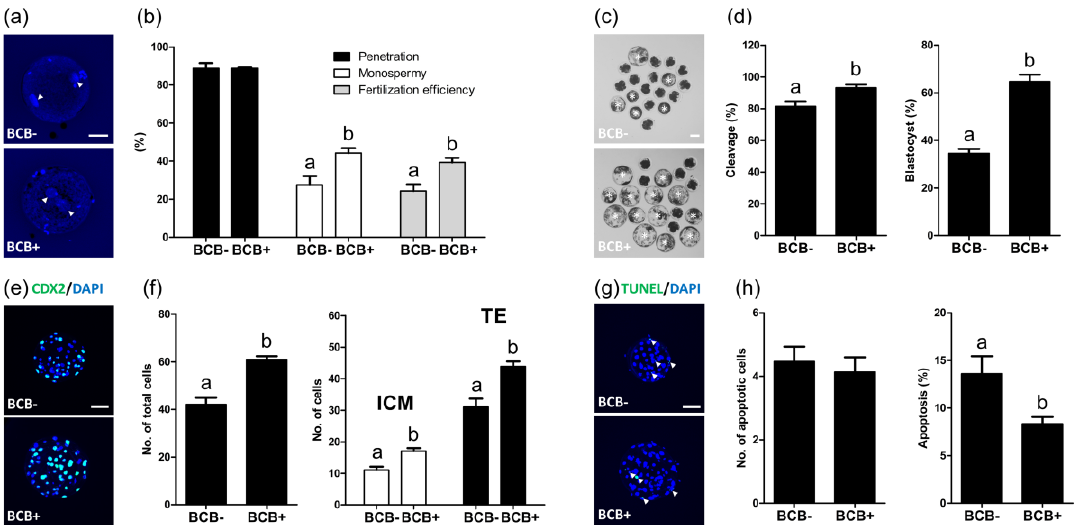
porcine oocytes. ( a ) Representative photomicrographs of pronuclear stage zygotes developed from BCB- and BCB+ oocytes. ( b ) The penetration rate (percentage of penetrated oocytes/total inseminated oocytes), monospermy rate (percentage of oocytes containing only one male pronucleus/total oocytes penetrated), and fertilization efficiency (percentage of monospermic oocytes/total oocytes inseminated) of the zygotes developed from BCB- and BCB+ oocytes. ( c )